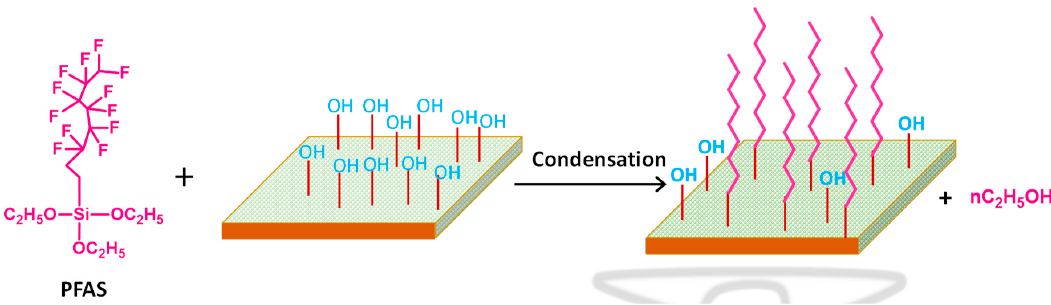
Figure 22. Schematic diagram of the surface modification procedure: ( A ) Surface silylation, ( B ) graft polymerization, and ( C ) resultant covalently-bonded PVP chain.